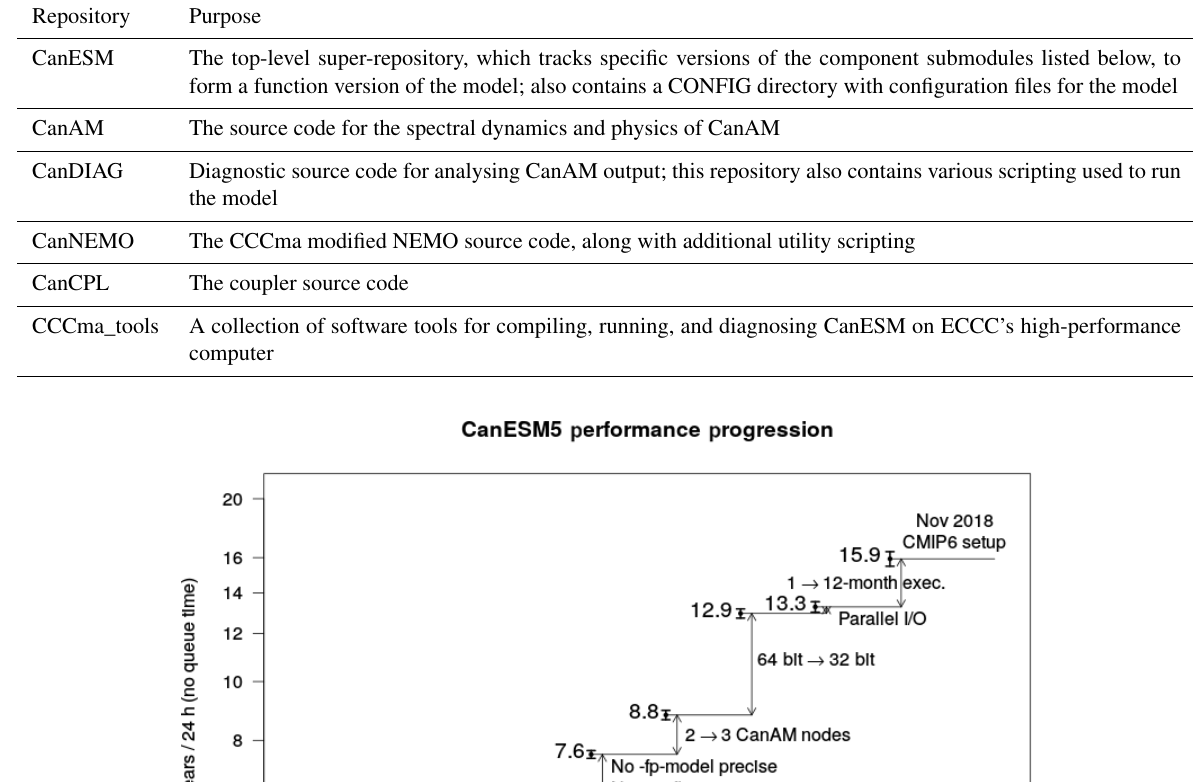
Table 1. Code structure and repositories.